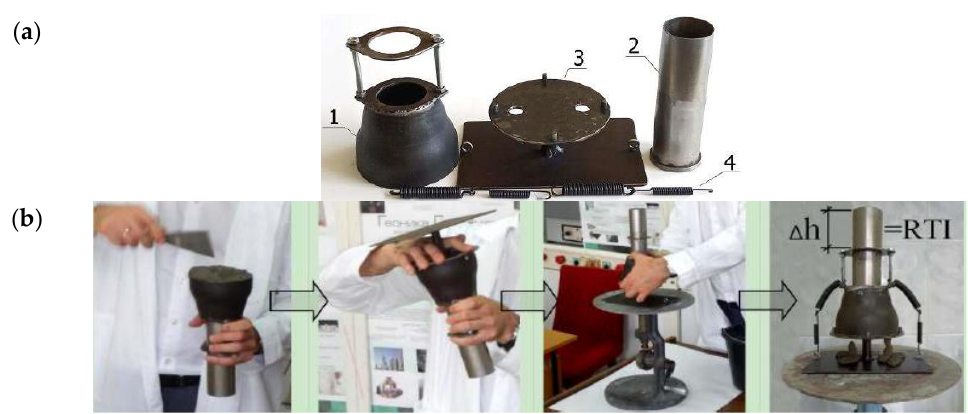
Figure 3. Developed device for determining the rheotechnological index ( a ) and the sequence for determining the RTI ( b ).